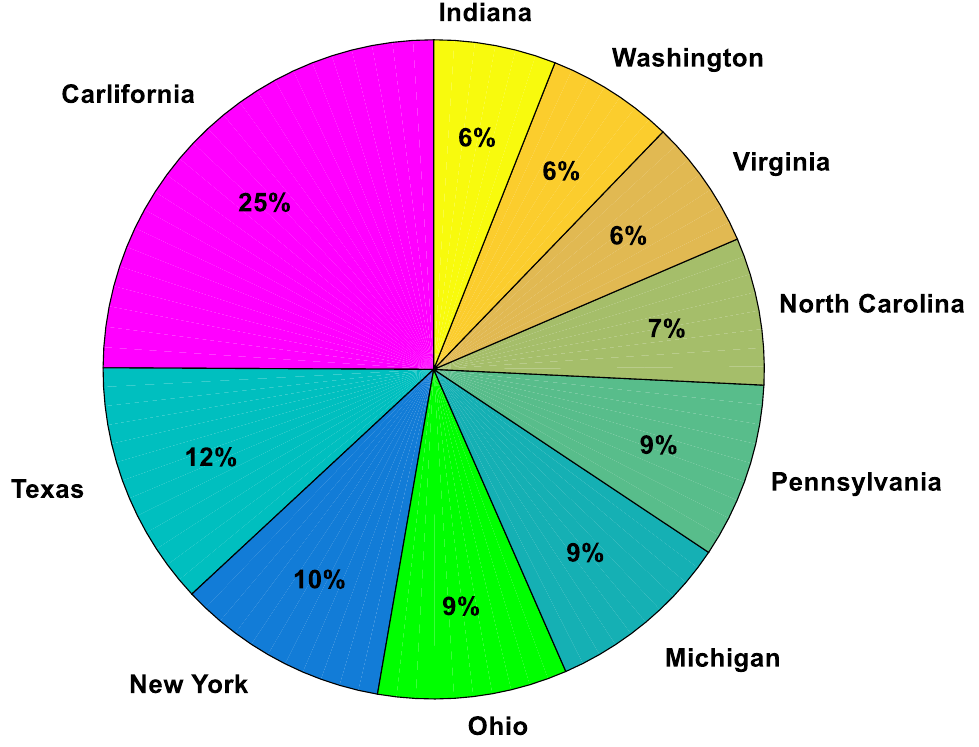
Figure 3. Blackout events in different USA states